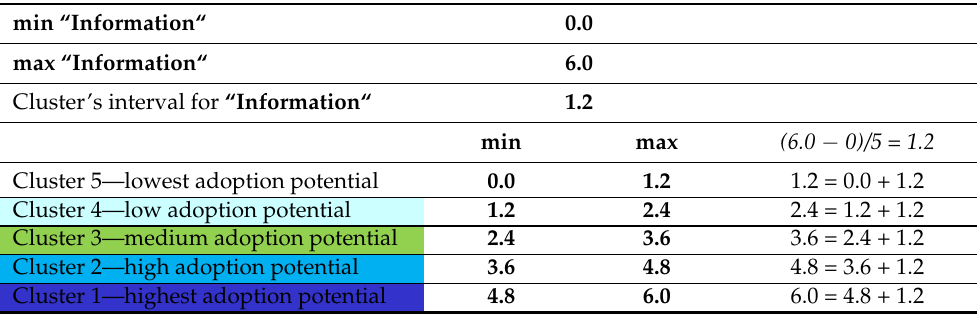
Table 14. Calculations for the “cluster interval” for variable